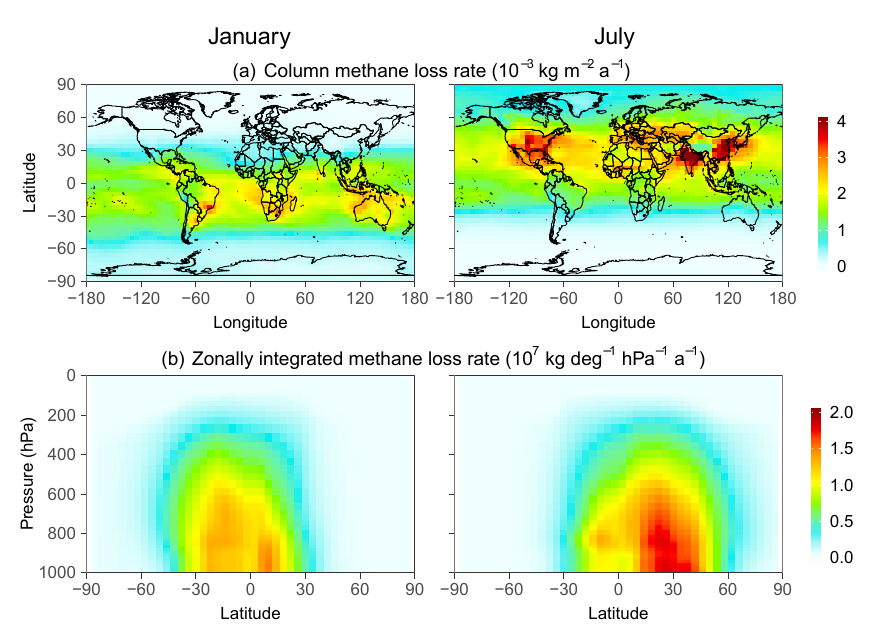
Figure 1. Monthly methane loss rate from oxidation by OH in January and July 2015 computed with the GEOS-Chem model (Wecht et al., 2014). The top panels show the column loss rates and the bottom panels show the zonally integrated loss rates.